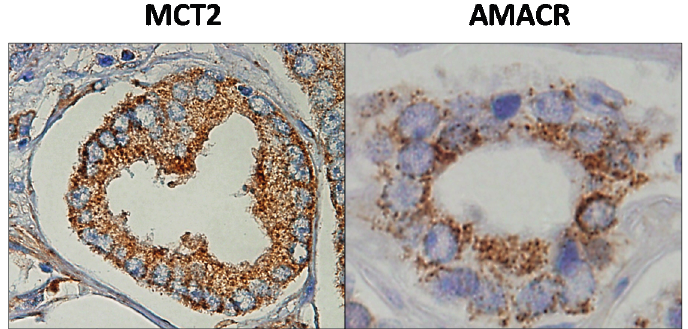
Figure 2. MCT2 and α -methylacyl-CoA-racemase (AMACR) expression in a prostate malignant gland by immunohistochemistry. Both proteins exhibited a punctuated staining in the cytoplasm of malignant